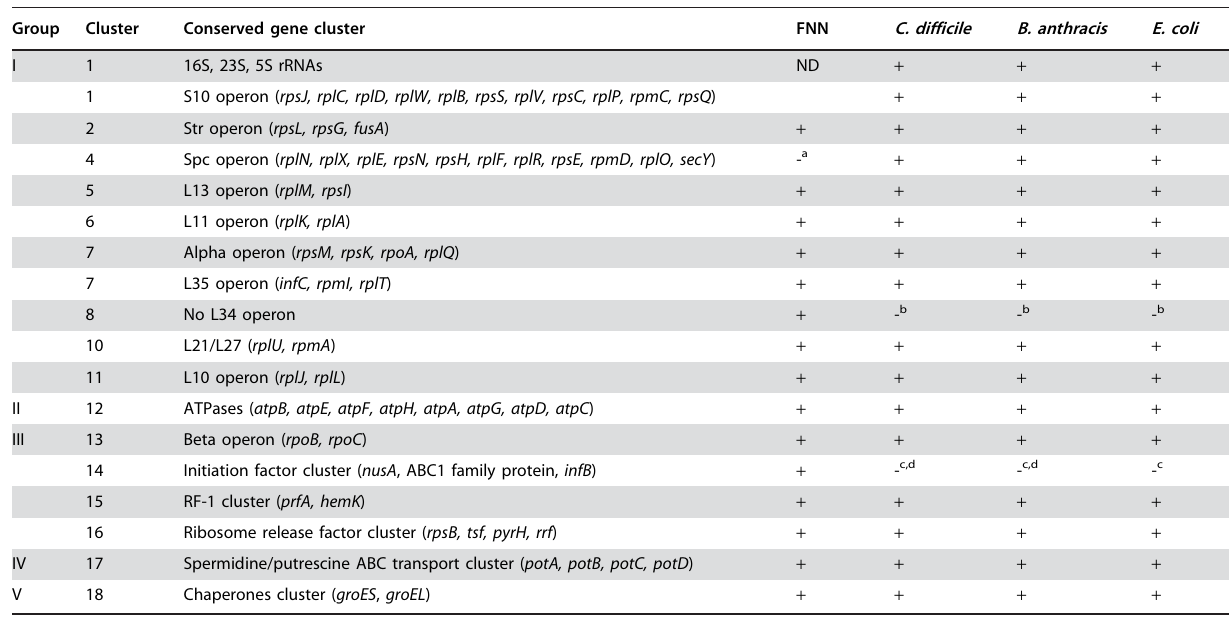
Table 2. Conserved gene clusters/operons in FNP. .. ... .... ... ... .... ... ... .... ... ... .... ... ... .... ... ... .... ... ... .... ... ... .... ... ... .... ... ... .... ... ... .... ... ... .... ... ... .... ... ... .... ... ... . Group Cluster Conserved gene